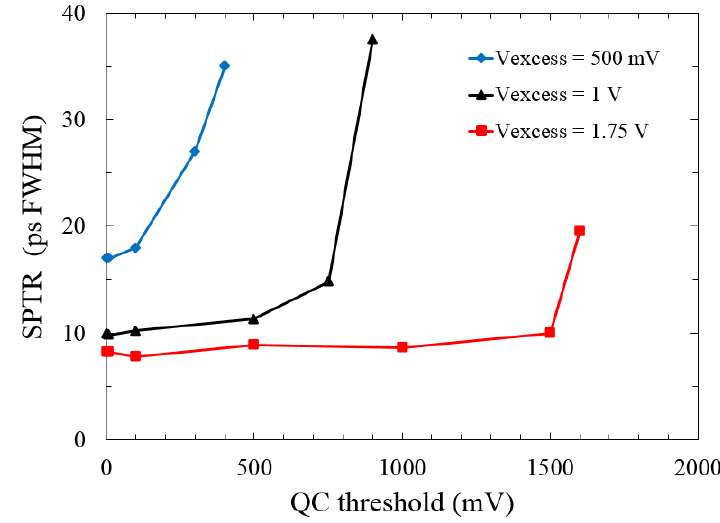
Figure 12. SPTR as a function of the QC threshold for different excess